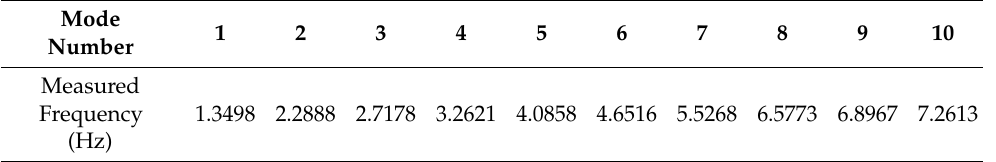
Table 7. Measured frequencies of the cable network obtained from free vibration.